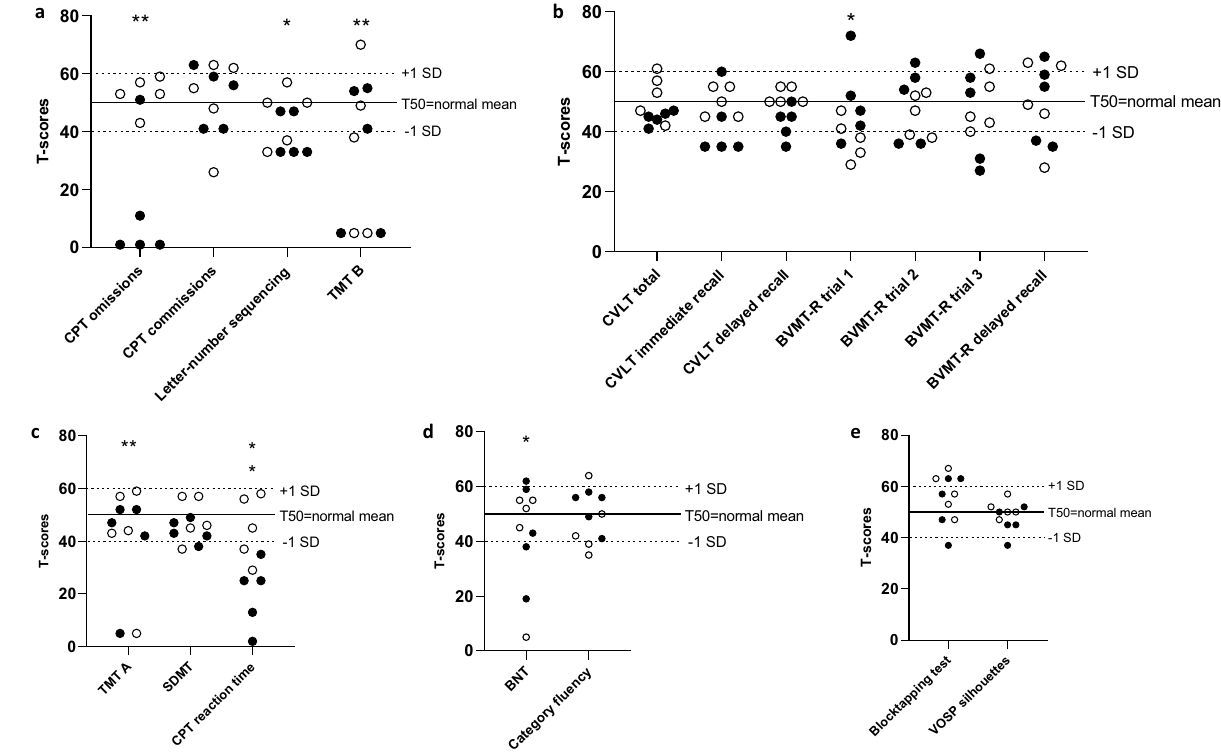
Figure 3. ( a–e ) Neuropsychological test results within five cognitive domains ( a ) executive functions, ( b ) learning and memory, ( c ) speed and attention, ( d ) language, ( e ) visuospatial functions, plotted as individual T-scores. oper circle = younger ages (24; 28; 32; 34; 35 years); filled circle = older ages (52, 74, 76, 82, 85 years). Significant group differences compared to normal data (Fig. 2) are indicated by * ( p < 0.05) or ** ( p < 0.001). BNT Boston naming test, BVMT-R Brief visuospatial memory test revised, Cat. Category, CPT continuous performance test, CVLT California verbal learning test, SD standard deviation, SDMT Symbol digit modalities test, seq. sequencing; TMT Trail making test, VOSP Visual object and space